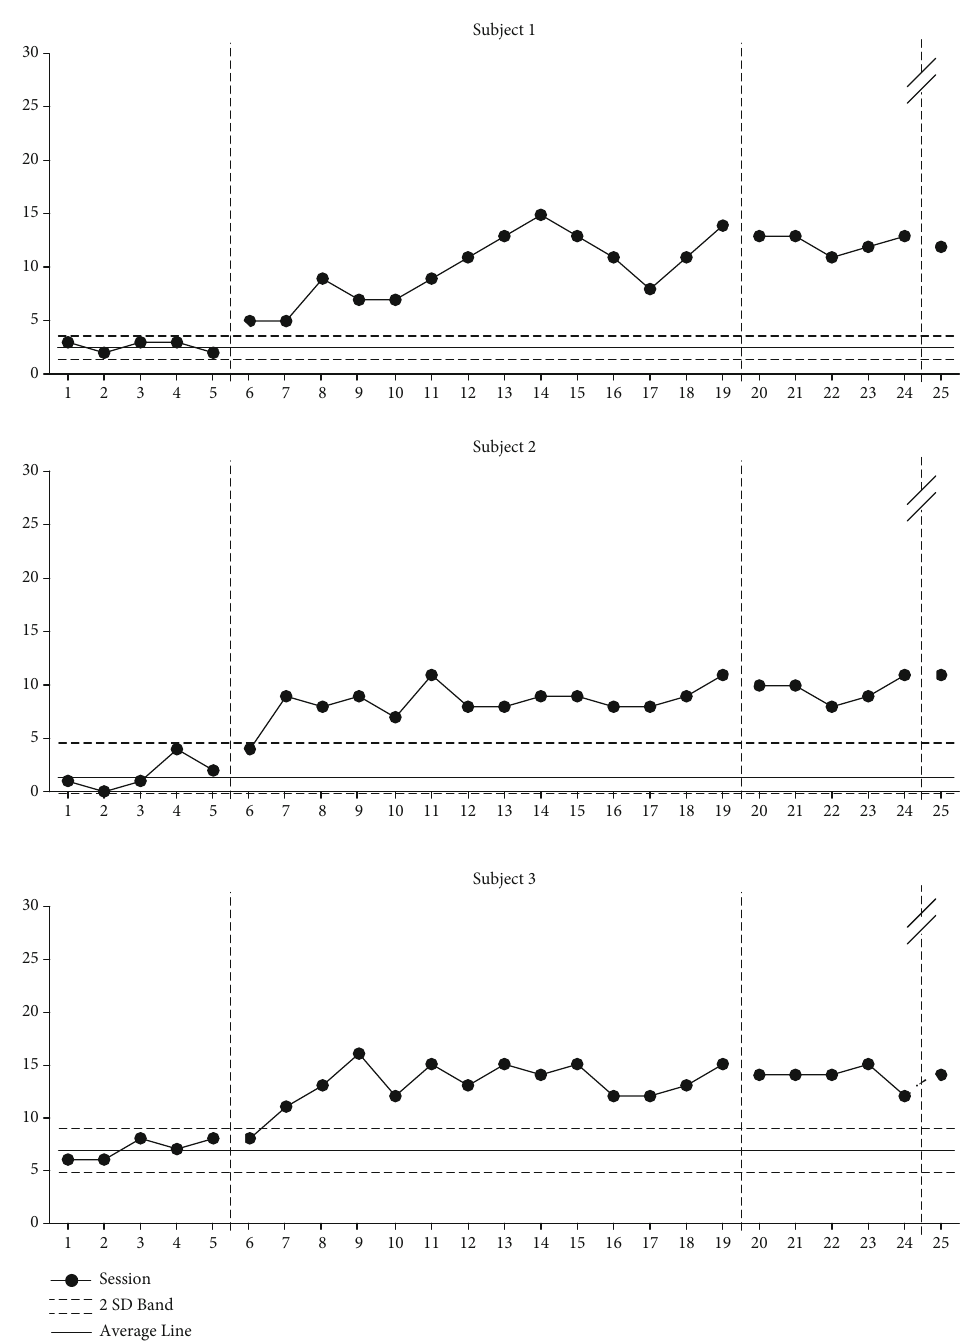
Figure 3: Changes in heeds